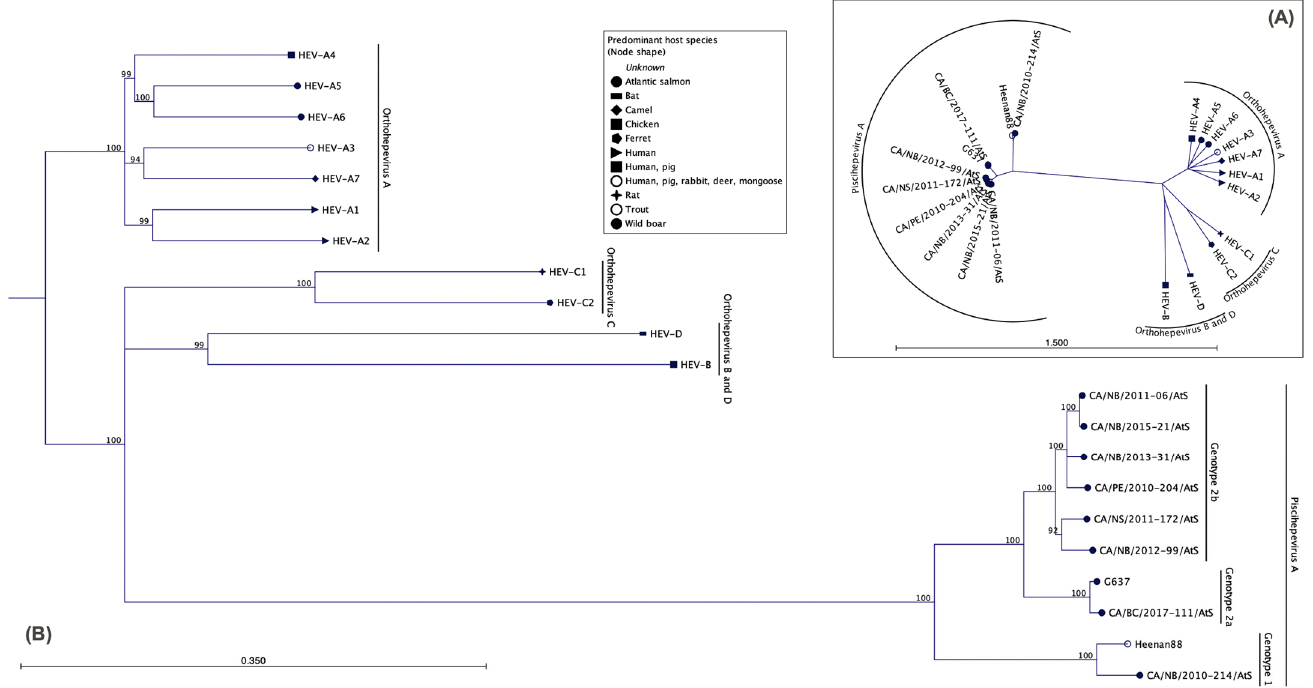
Figure 2. Phylogenetic trees showing the genetic relationship of complete genome sequences of cutthroat trout virus isolates from Canada with other hepevirus isolates ( A ) as radial tree, without bootstrap values); ( B ) as phylogram tree including bootstrap values and the identified sub-genotypes within cutthroat trout virus isolates.